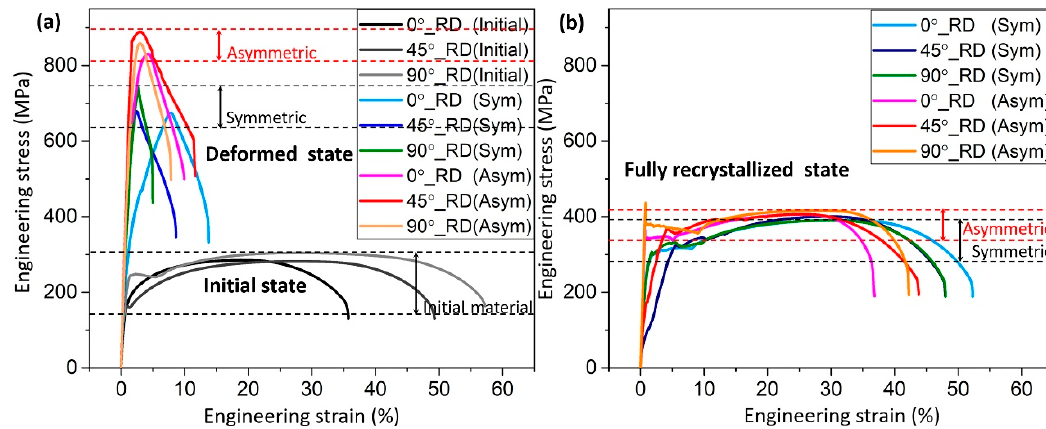
Figure 10. Engineering stress–strain curves in tensile testing after deformation by 75% thickness reduction in a pass ( a ) and recrystallization ( b ) for 100 s at 660 ± 10 °C.